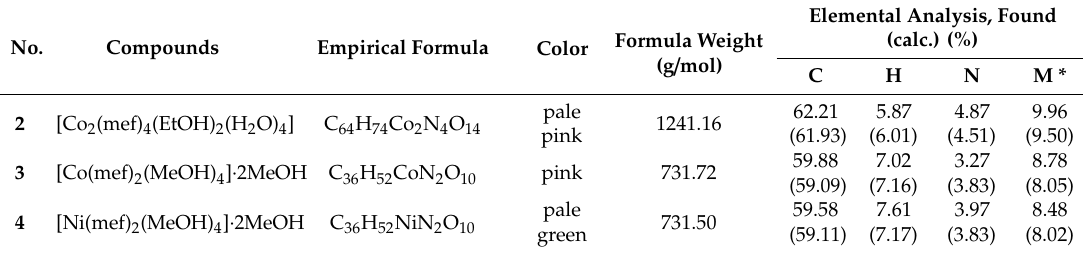
Table 2. Crystal data and structure refinement parameters for 2 – 4 .